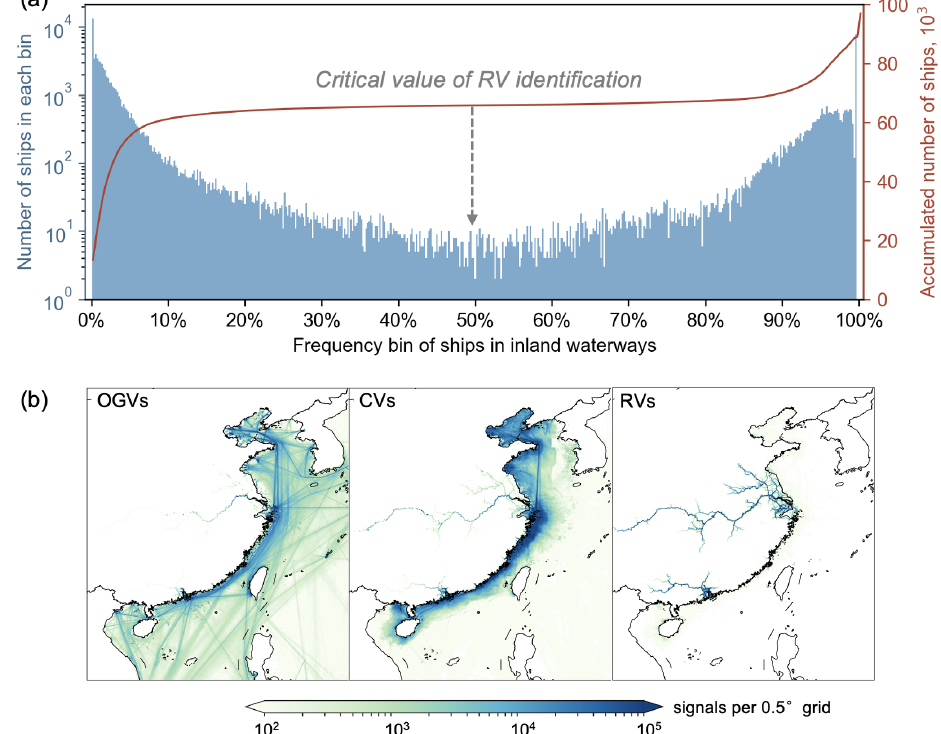
Figure 5. Identification test and results of OGVs, CVs and RVs. (a) Frequency test of ships in inland waterways. (b) Spatial distribution results of AIS signals of OGVs, CVs and RVs. The sample year is 2016.